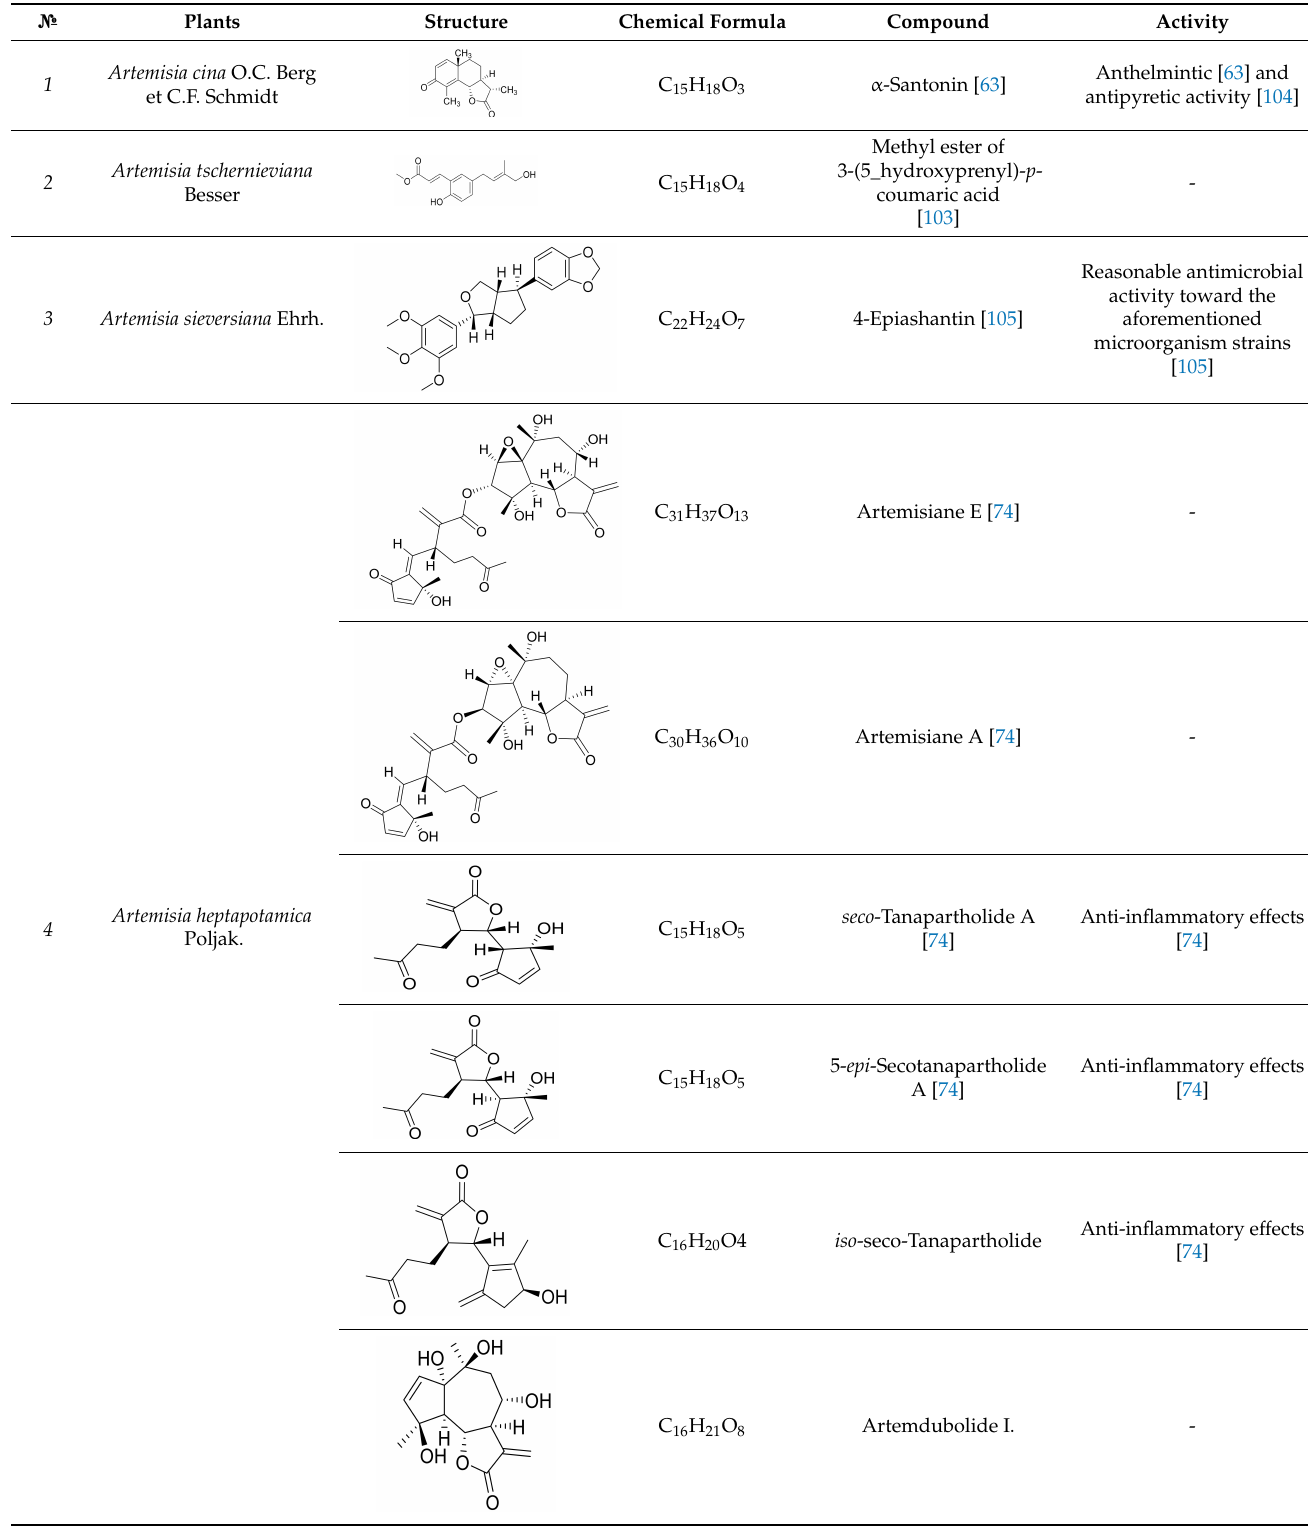
Table 3. Secondary metabolites isolated from Artemisia L. species of Central